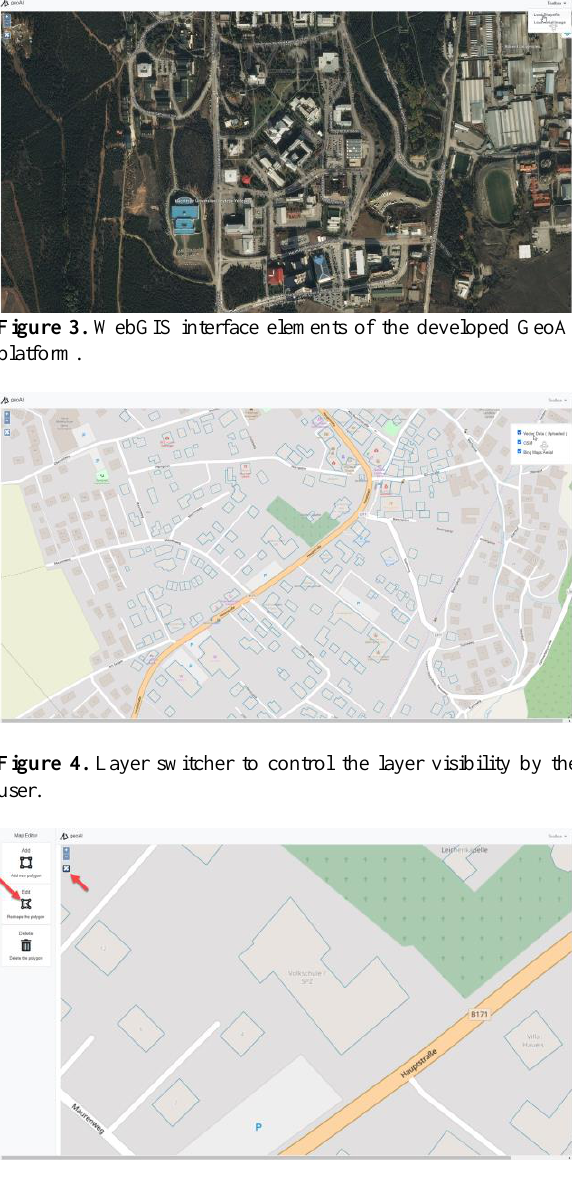
Figure 5. The map editor menu, which can be opened by clicking the tools symbol below the zoom icon.